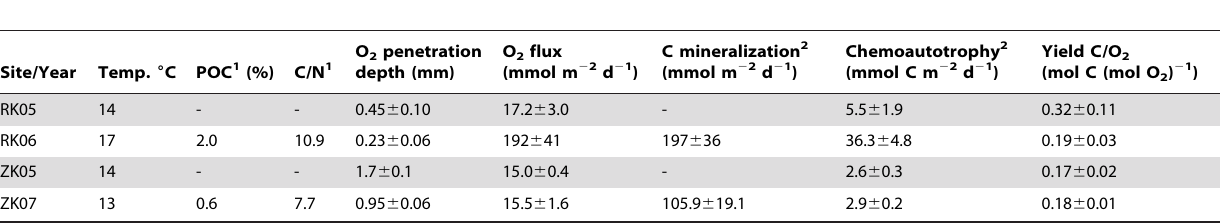
Table 1. Sediment in-situ temperature, sediment characteristics, oxygen consumption rates, carbon mineralization rates, chemoautotrophy rates and yields (averages 6 standard deviations, N=2) for the coastal marine sediments in this study.